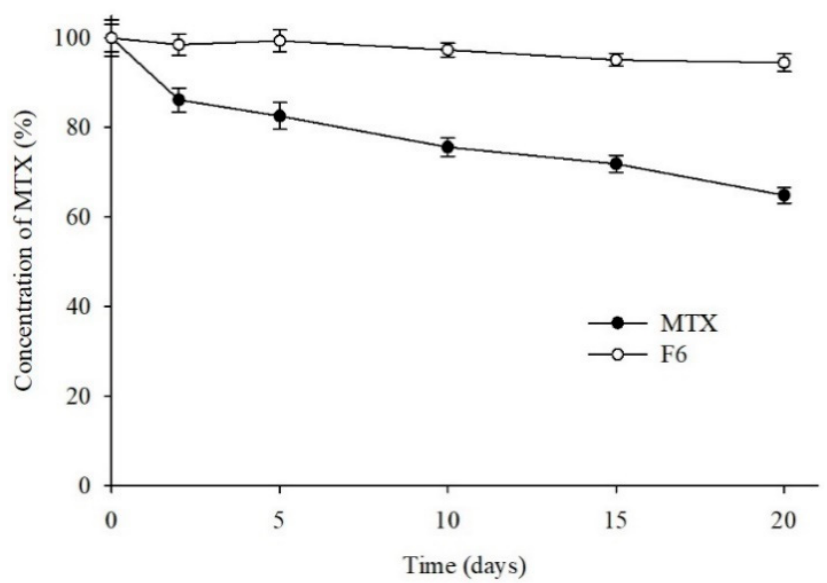
Figure 6. Photodegradation profile of MTX formulations. Each MTX sample was exposed to UV light (250 W/m 2 ) for the indicated periods, and its purity was assessed by HPLC.